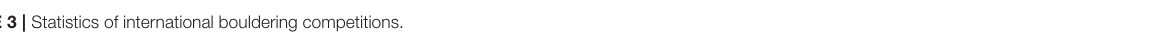
Number of Successful attempts attempt per duration boulder